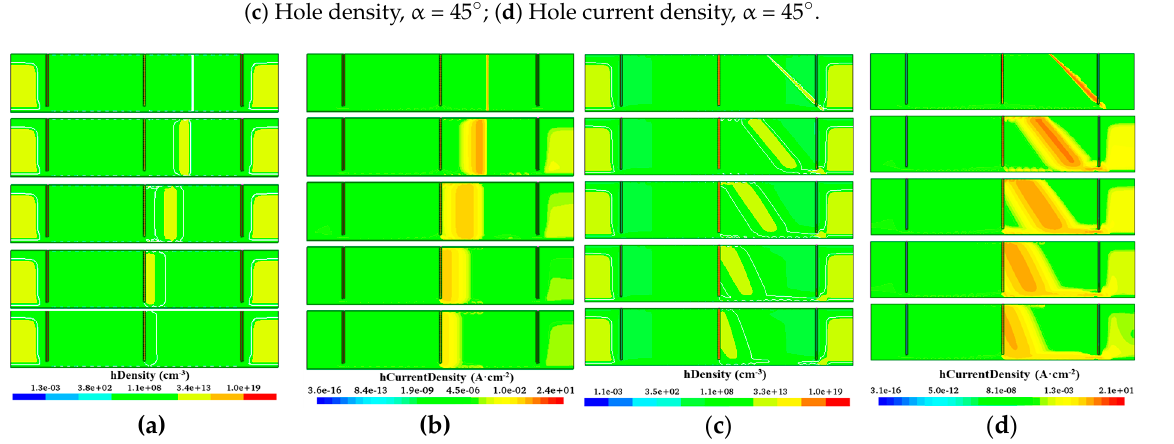
Figure 12. Charge collection efficiency: ( a ) Incident at D = 250 μ m and D = 500 μ m vertical surfaces, respectively; ( b ) Incident at α = 45° and α = 135°, respectively. In the following part of the study we will mainly study the influence of drift path on the CCE, the influence of deep level capture center [28,34] on the CCE is ignored in the simulation for clarity. For a small area 3D trench electrode silicon detector, the CCE is independent of incident position in a non-radiation environment [33], but the CCE of a